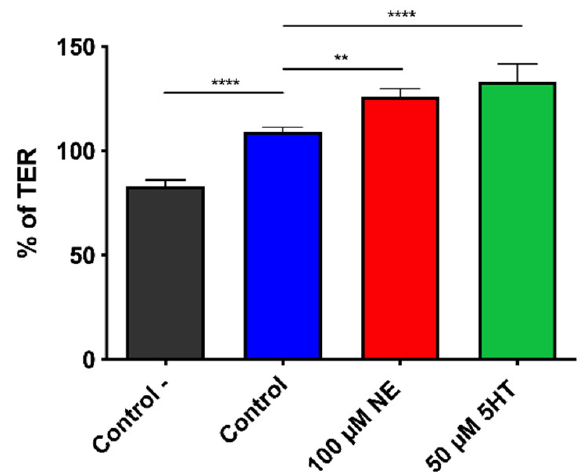
Figure 3. Modulation of Caco-2/TC7 TER after 20 h exposure to E. faecium NCIMB10415 in control conditions (blue) or treated with 100 µM NE (red) or 50 µM 5HT (green). Both treatments of the bacteria improve the TER compared to the control condition. In the bar chart is presented also the % of initial TER for the untreated Caco-2/TC7 cells as ‘Control–’ (black). Results are expressed as % of initial TER ± SEM. **** p ≤ 0.0001, ** p < 0.01.